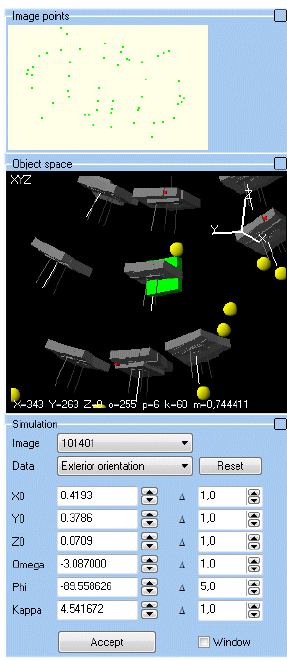
Figure 11: Interactive modification of orientation data with visualized effect in image and object space